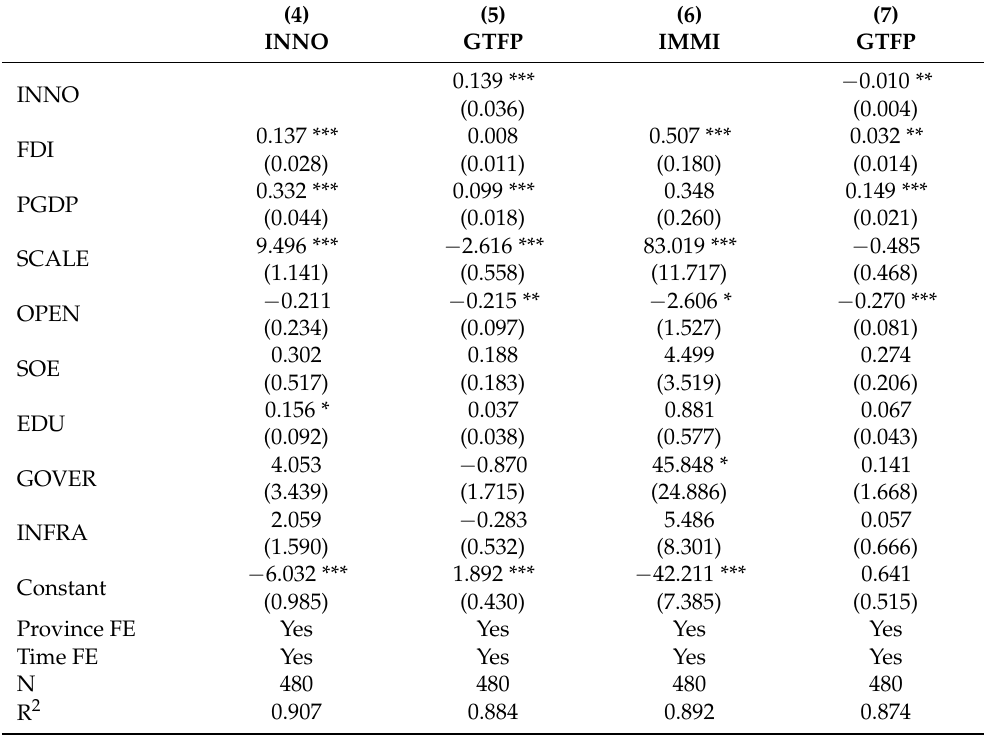
Table 4. The mediating effect of independent innovation and imitation